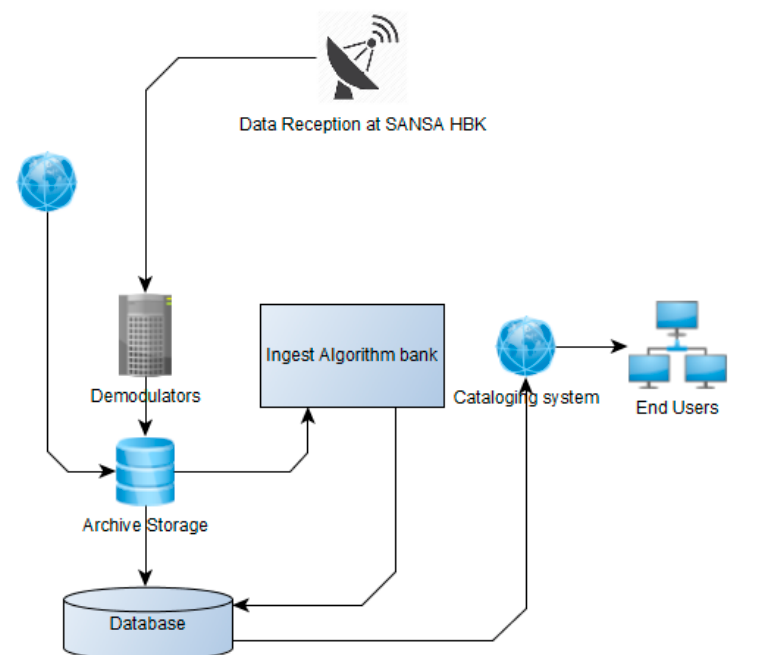
Figure 4. High-level overview of ingest module.